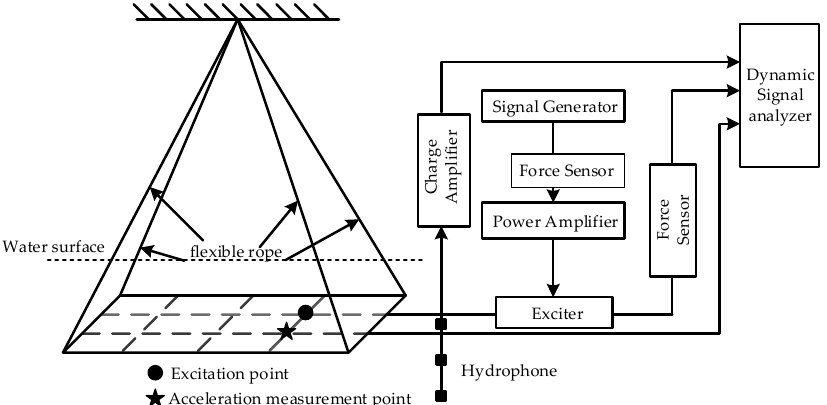
Figure 6. Schematic diagram of the underwater vibration and acoustic tests.